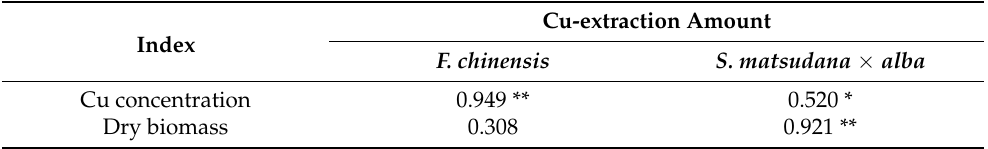
Table 5. Correlation analysis between Cu-extraction amount with Cu concentration and dry biomass of above-ground parts of F. chinensis and S. matsudana × alba